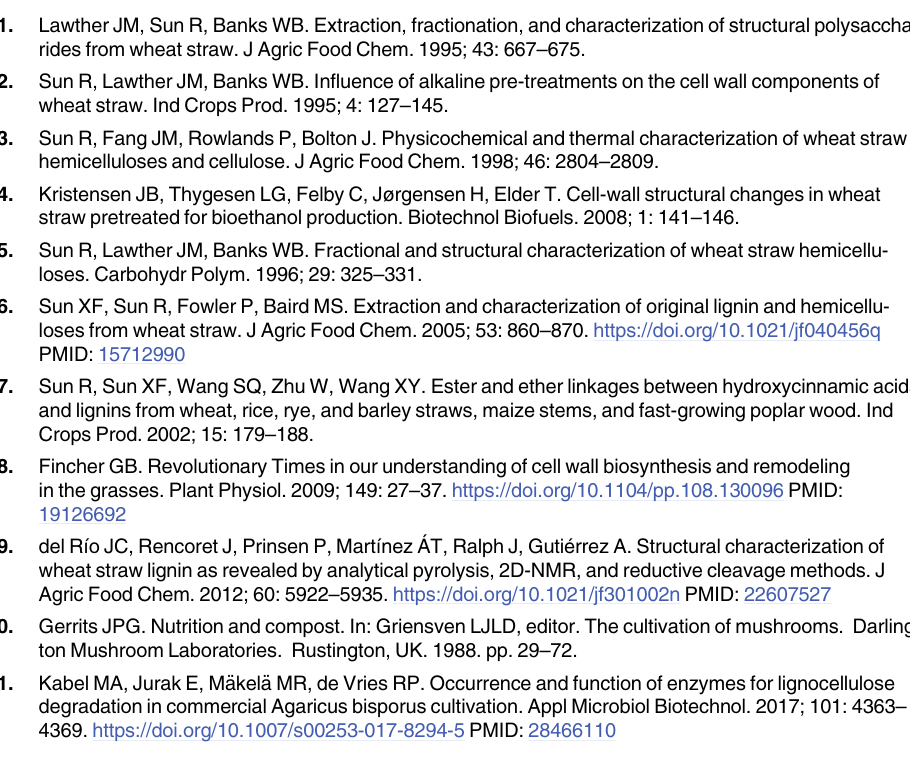
S3 Table. Overview of GH43_36 in 145 fungal species. S1 Fig. HPAEC elution profiles of WAX digested with endoxylanase (EX1; based on [31,47]). Single and double arabinoxylan oligomers and oligomers with both single and double substitutions are schematically represented. Ovals represent xylosyl residues and diamonds represent arabinosyl residues. S2 Fig. All replicates of HPAEC chromatograms of endoxylanase predigested WAX incu- bated with concentrated compost